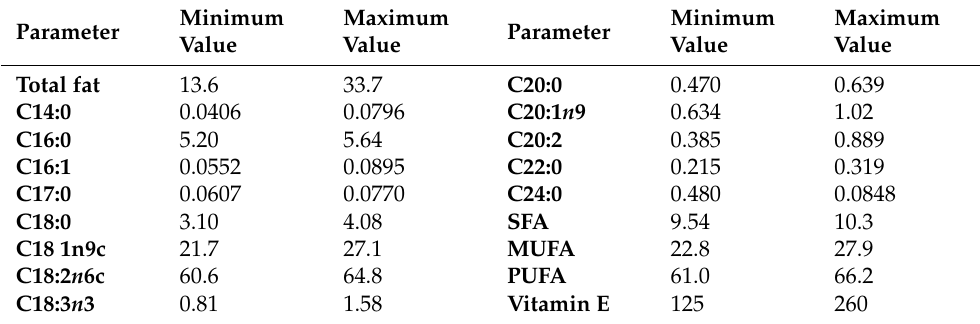
Table 2. Maximum and minimum values obtained with the analysed